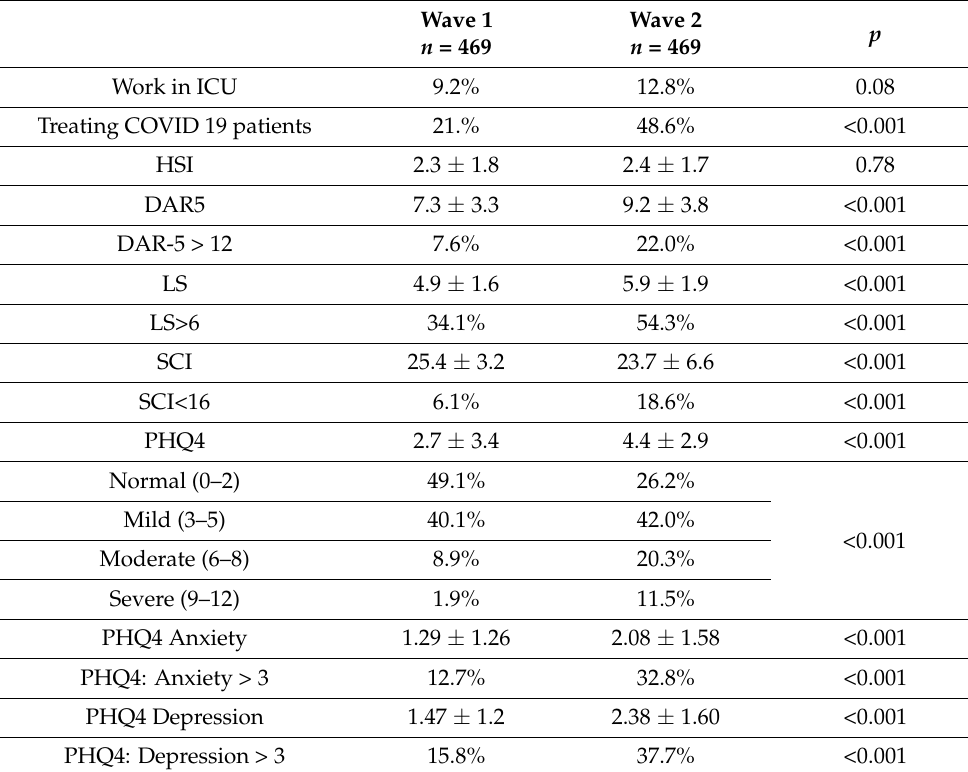
Table 2. Differences between socio-demographic characteristics, mental health indices and sleep quality of the responders that were followed up during both first and second waves (Mean ±